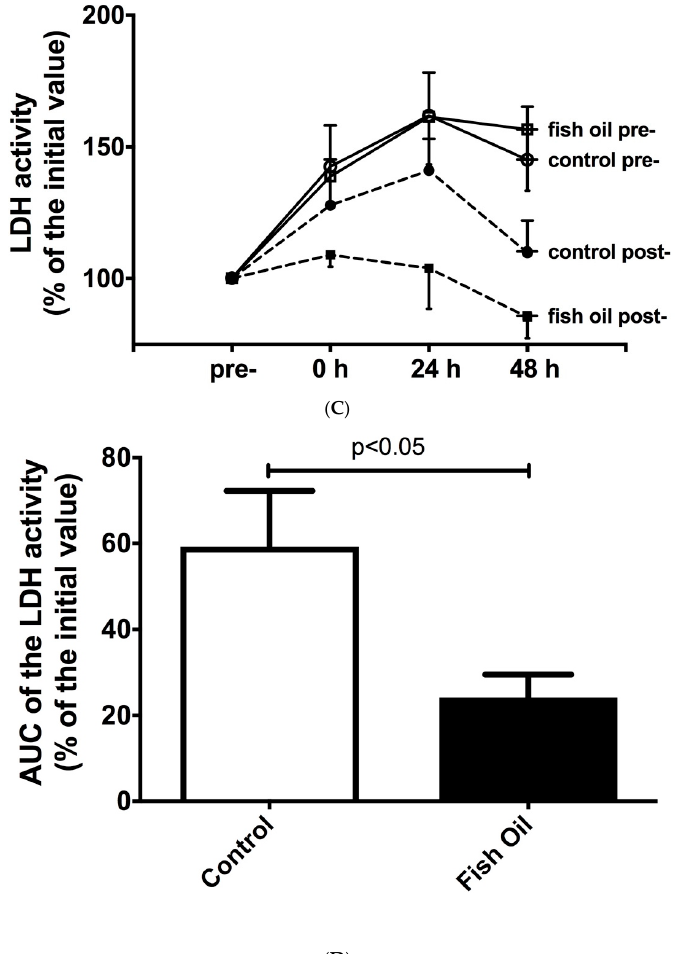
Figure 1. Effect of the fish oil supplementation on plasma activity of ( A ) creatine kinase (CK) and ( C ) lactate dehydrogenase (LDH), in response to a single bout of strength exercises, at baseline (pre-training period) and after 6 weeks of daily undulating strength training (post-training period). On the left, time-dependent plasma CK and LDH activities (before and 0, 24, and 48 h after a single bout of strength exercises). On the right, decrease in the area under curve (AUC) of the temporal plasma CK ( B ) and LDH ( D ) activities after 6 weeks of daily undulating strength training. Results presented as mean ± S.E.M. p < 0.02 for CK activity, and p < 0.05 for LDH activity, comparing control group with fish oil group.